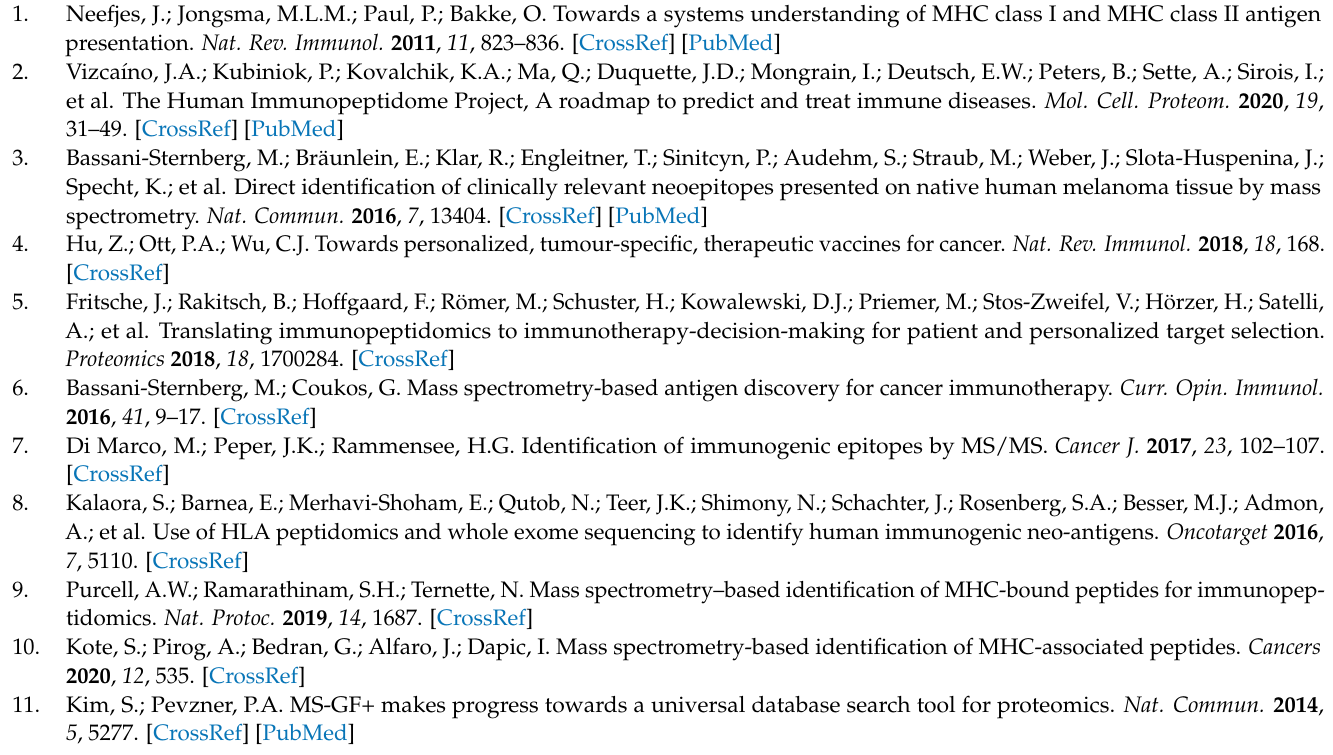
Figure S9. The sequence logo comparison of immunopeptides in various datasets by conventional search, IntroSpect search and from IEDB; Figure S10. The comparison of PCC aaf at each position between IntroSpect and SpectMHC; Figure S11. Spectra of neoepitope candidates; Figure S12. Peptides identified by IntroSpect, SpectMHC and the conventional search with PEAKS; Figure S13. Neoepitopes identified by IntroSpect, SpectMHC and the conventional search in the HCT116 dataset; Table S1. Randomly selected peptides identified by IntroSpect and conventional database search with Comet and MaxQuant were confirmed by spectral validation; Table S2. The neoepitope candidates identified from HCT116 cell line; Table S3. The effect of clustering number on the performance of